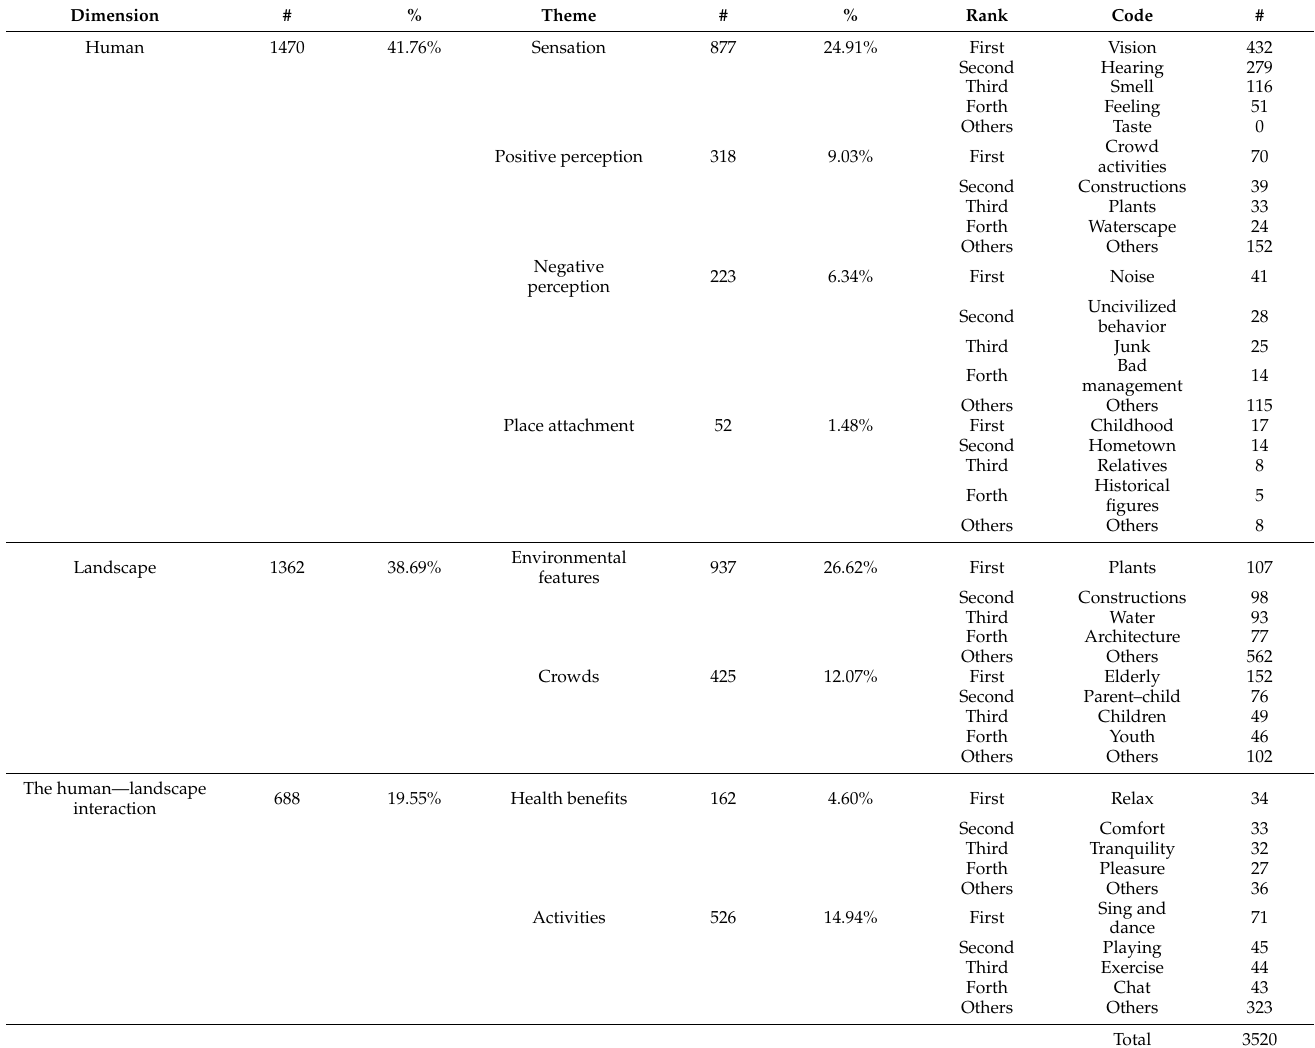
Table 4. Young adults’ perception encoding table. The code number and proportion of the young adult’s parks perception for each dimension \ theme \ code, “#” stand for code number, ”%” stand for proportion, we chose the 4 codes with the most frequency for each theme to represent, and the rest were put into